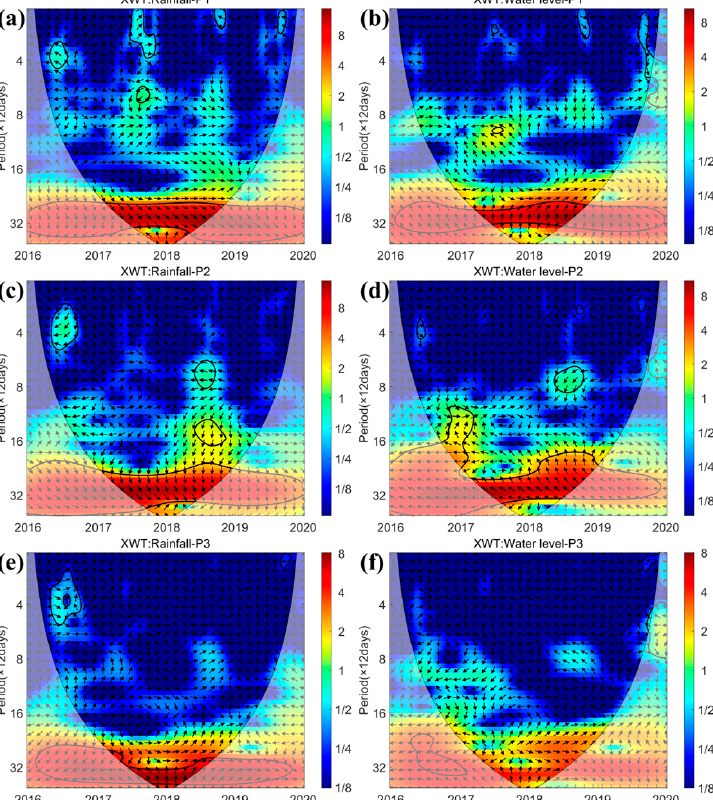
Figure 12. XWT results for different time series data: ( a , c , e ) denote the cross-wavelet power spectrum of precipitation and nonlinear deformation of feature points p1, p2 and p3, respectively; ( b , d , f ) denote the cross-wavelet power spectrum of reservoir water level and nonlinear deformation feature points p1, p2 and p3, respectively. The arrow pointing to the right shows a positive correlation, whereas the arrow pointing to the left represents a negative correlation, for a more detailed explanation of the arrows, please refer to Figure 3. Table 3. Average phase angle and time lag of rainfall, reservoir water level, and nonlinear displace- ment.